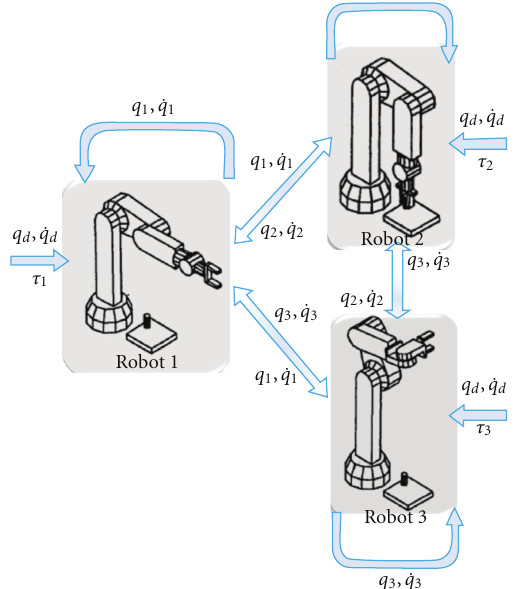
Figure 2: Robot network using bidirectional communication.